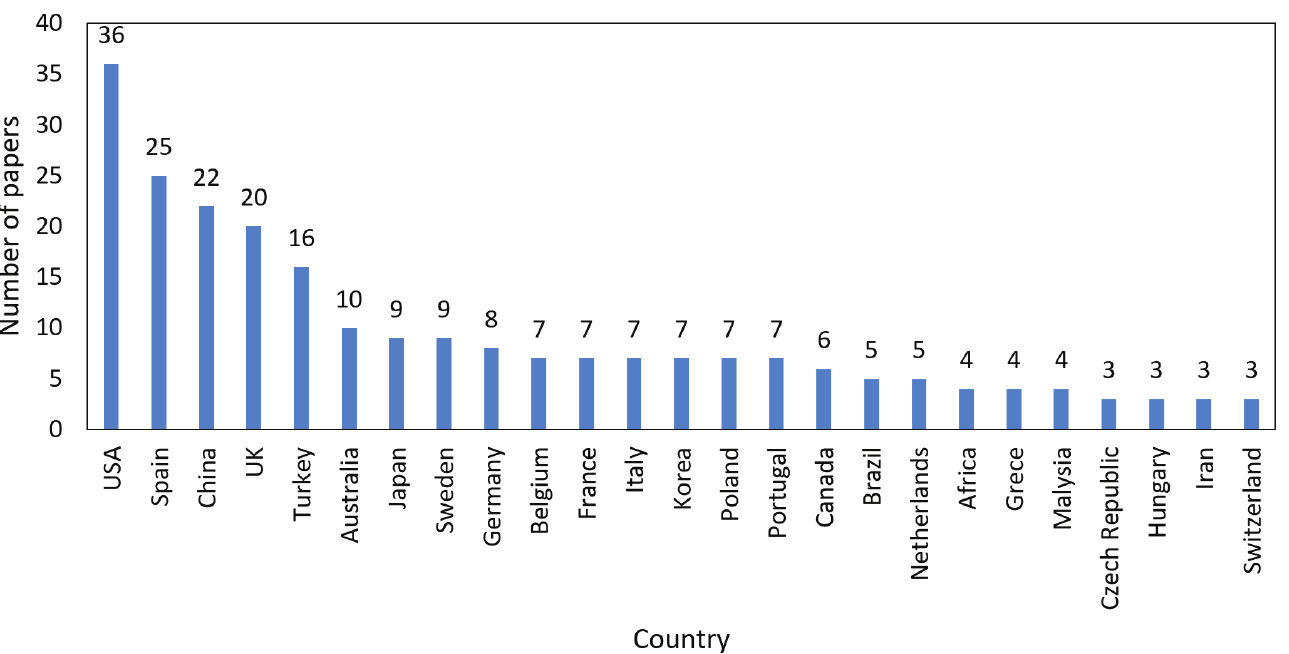
Figure 5. Number of papers on human landscape perceptions by country (The number of papers does not add to 255 as some papers included more than one